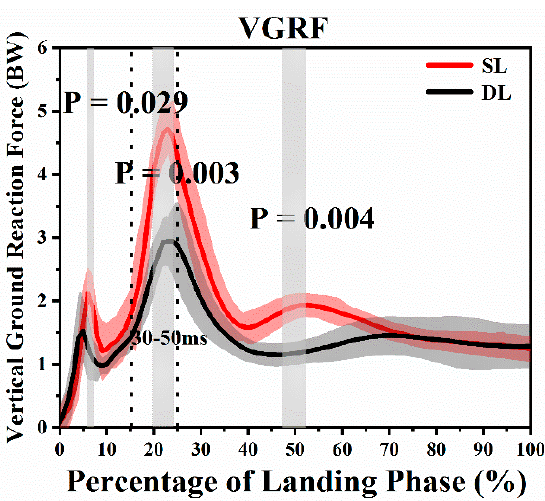
Figure 5. The Statistical Parametric Mapping (SPM) results between single-leg landing (SL) and double-leg landings (DL) tasks following a spike, depicting the mean vertical ground reaction force (VGRF) and standard deviation. Two dashed lines are the 30 and 50 ms time frame of initial contact. Grey shaded areas indicate that there are significant differences ( p < 0.05) between SL and DL during the spike landing phase. Table 1. Means ± standard deviations for the peak angle moment power and angular velocity of ankle knee and hip sagittal plane, peak VGRF and loading rate between SL and DL.